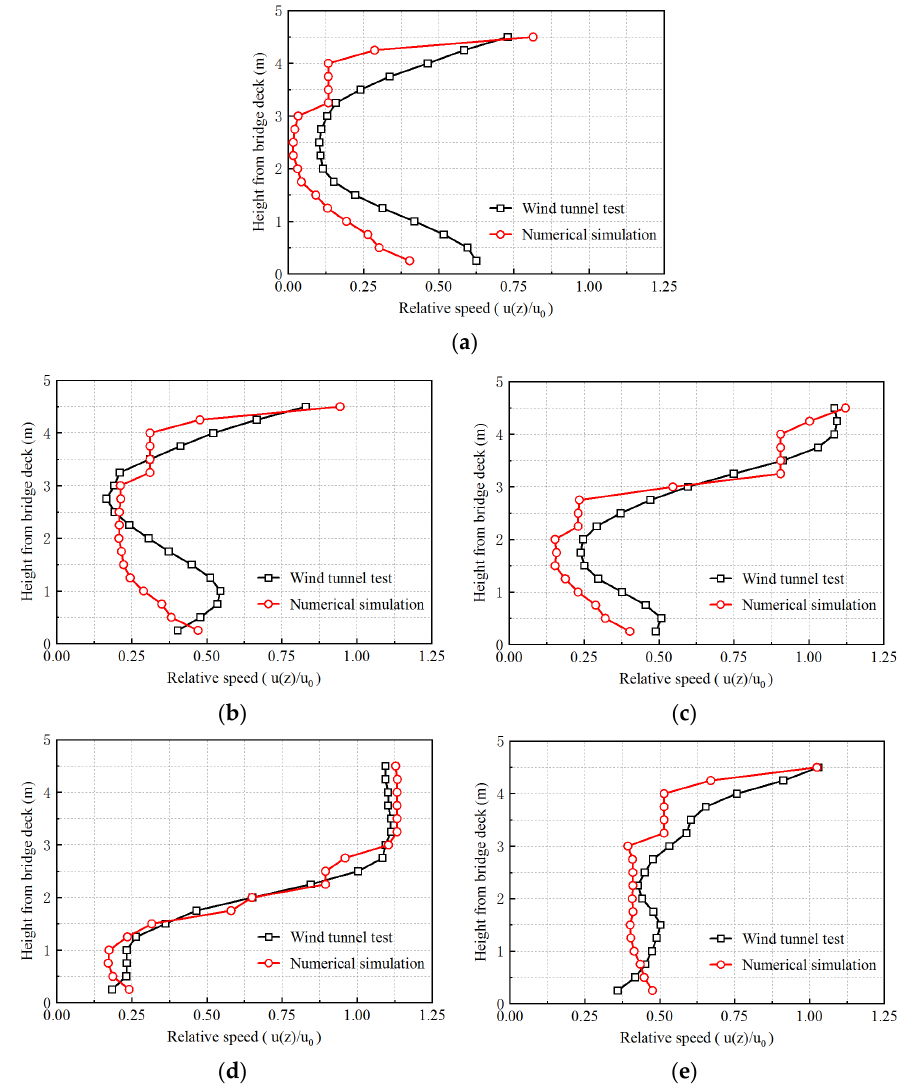
Figure 14. Comparison of relative wind speed values (u(z)/u 0 ) for different wind barriers in Lane 2 (( a ) Scheme 1; ( b ) Scheme 2-1; ( c ) Scheme 2-2; ( d ) Scheme 2-3; ( e ) Scheme 3).